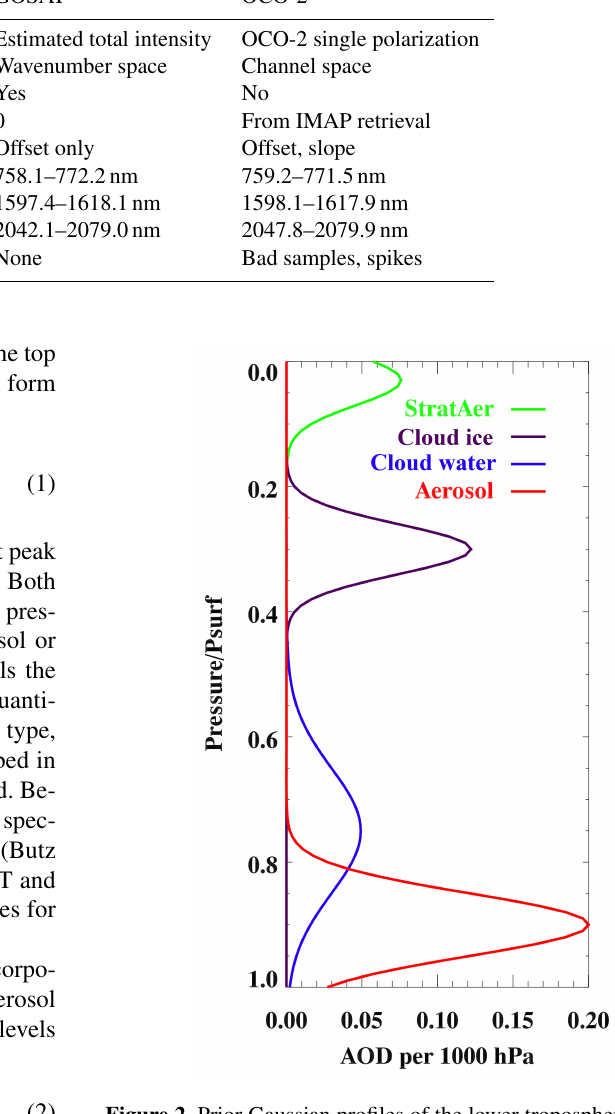
Figure 2. Prior Gaussian profiles of the lower tropospheric aerosol types (red), water cloud (blue), ice cloud (purple), and stratospheric aerosol (green). The local aerosol optical depth (AOD) per unit pres- sure at 755nm is plotted as a function of the relative pressure. The lower tropospheric aerosol prior optical depth is not fixed as for the other types, but rather is taken from a climatology described in the